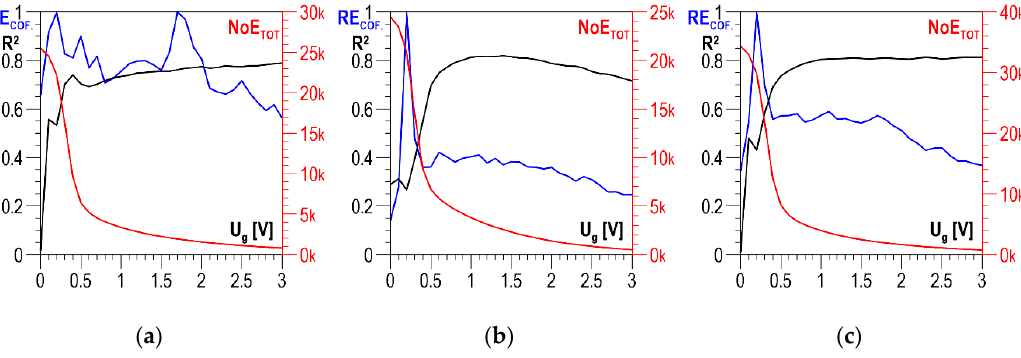
Figure 11. Averaged NoE TOT distributions and distributions of coefficients RE COF. and R 2 as a function of threshold voltage U g —DC01 steel ( a ) parallel direction; ( b ) normal direction; ( c ) absolute value